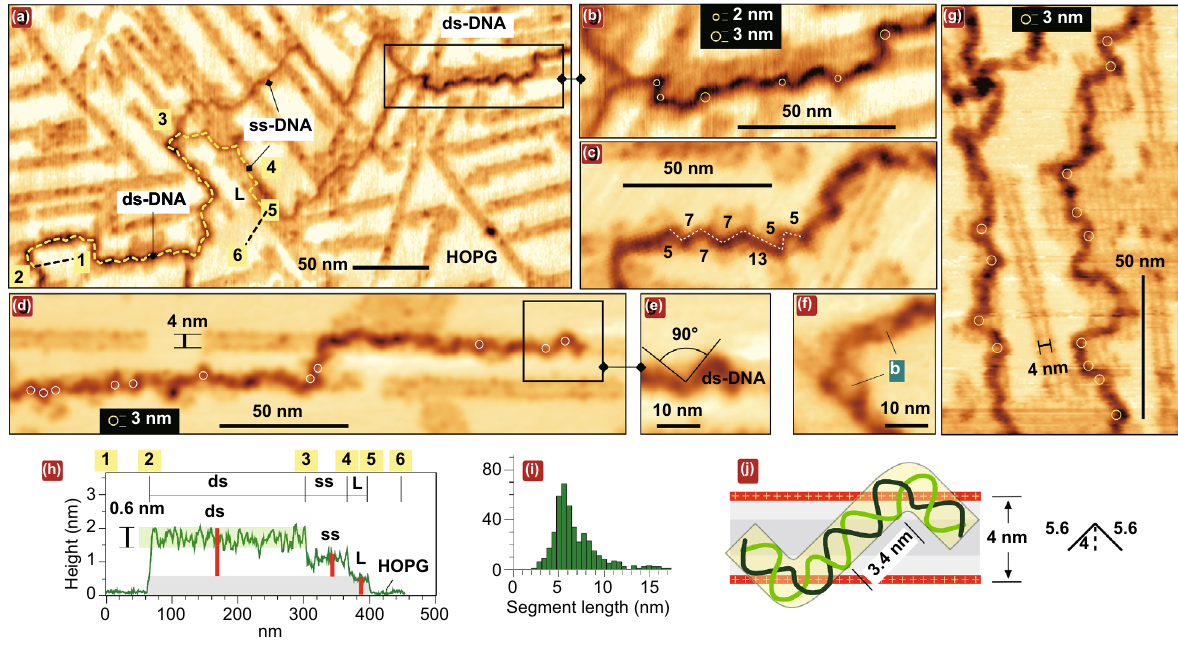
Fig. 5 The kinking and the geometric frustrations in the shape of DNA confined between positively charged rows of lamellar amines (θ = 0) and adsorbed on lamellar domains. a–g Representative AFM topography images in air (inverted height palette) of supercoiled circular M13 mp18 DNA ( a, b ) and linear pUC19 DNA ( c–g ). Some extremely curved sites are marked by the overlayed circles with dimeters of 2 nm and 3 nm. The full image of DNA in ( a ) is shown in Fig. S5. c The geometric frustration s in the DNA shape manifested in the undulation segments length variation (shown in nm). f The small melting bubbles ( b ) . g The DNA geometric frustrations on the lamellar domain. h The longitudinal DNA profile drawn along the dashed line between points 1 and 6 in (a) that includes ss‑ and ds‑DNA parts. i The histogram of the length distribution of the undulation segments. j The model of a segment of a minimal length terminated by the kink/anti‑kink pair sticked to opposite rows of lamellar